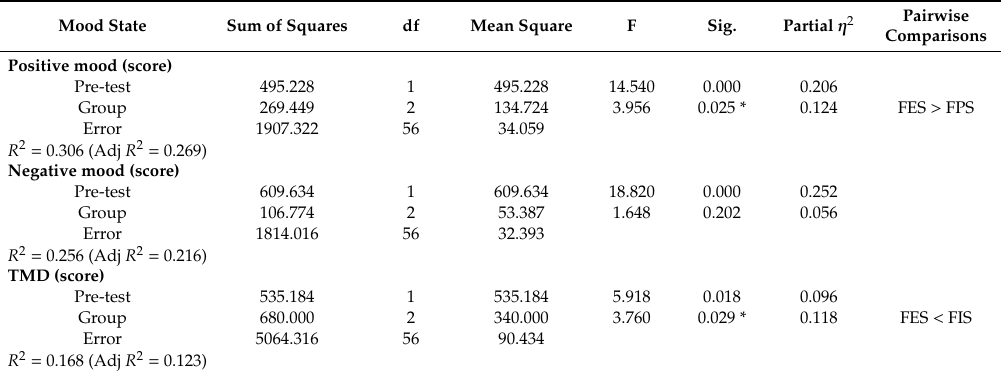
Table A2. E ff ect of bamboo forest space on the mood state across the experimental groups (covariates: pre-tests; dependent variables: